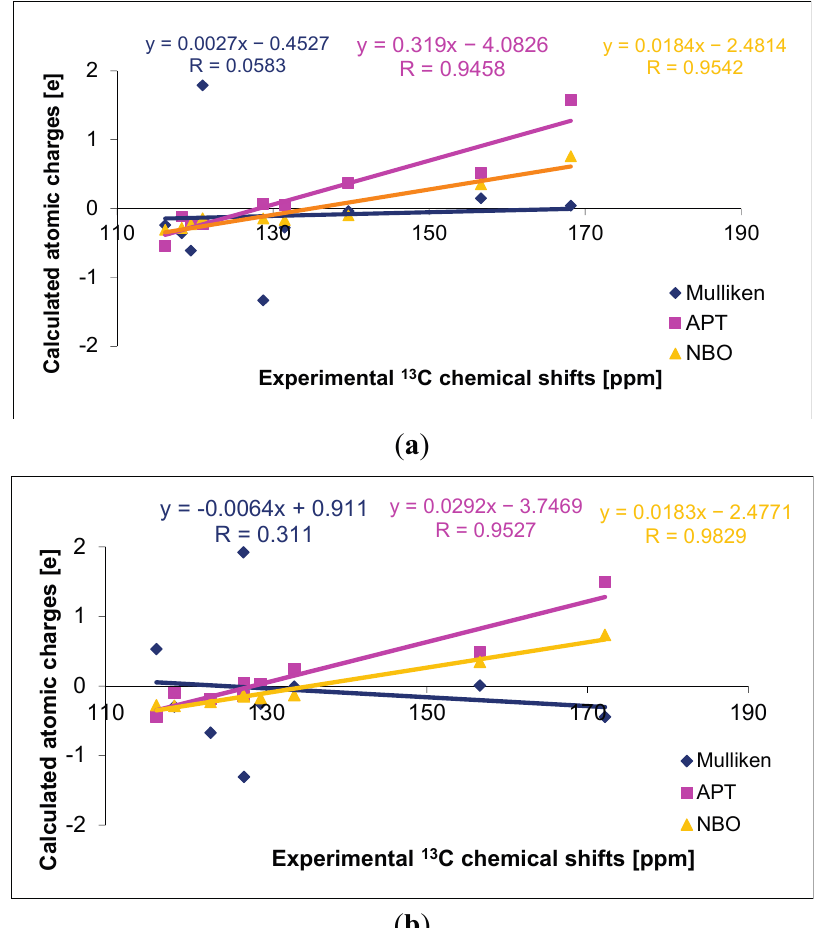
Figure 7. The correlation between the calculated atomic charges on carbon atoms in trans o -coumaric acid and ( a ) and Na o -coumarate ( b ) molecules and experimental 13 C-NMR chemical